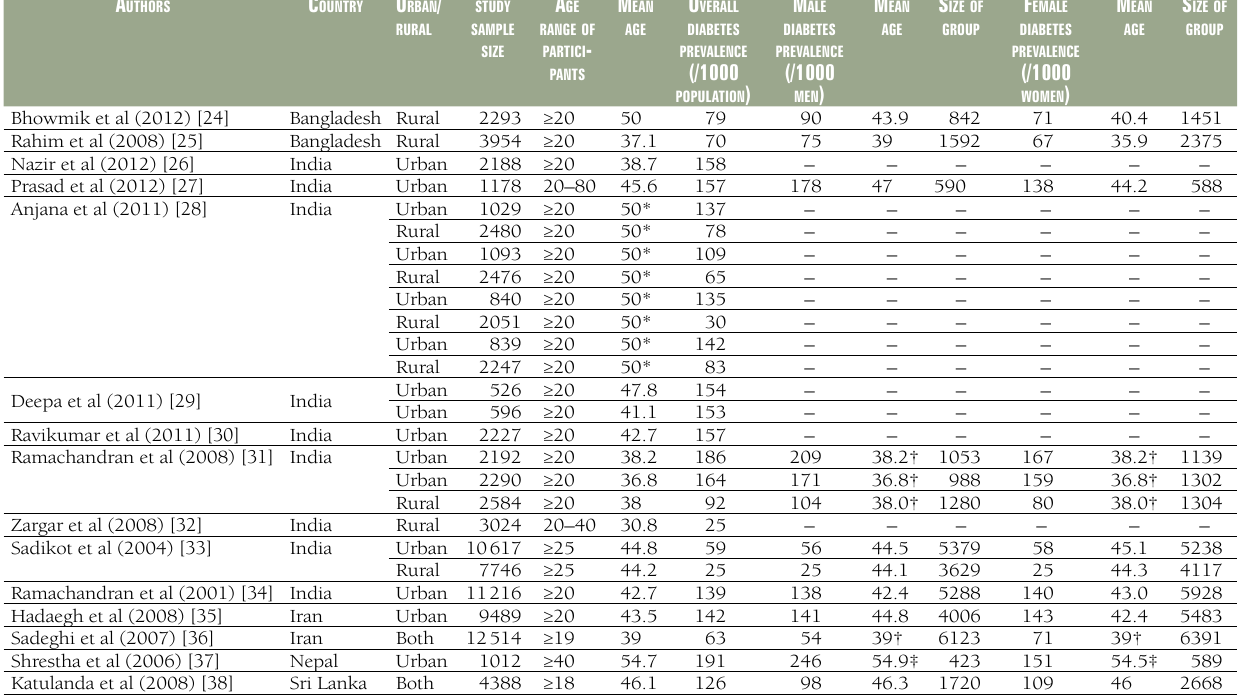
Table 8. Individual study prevalence data: FPG+OGTT combined studies